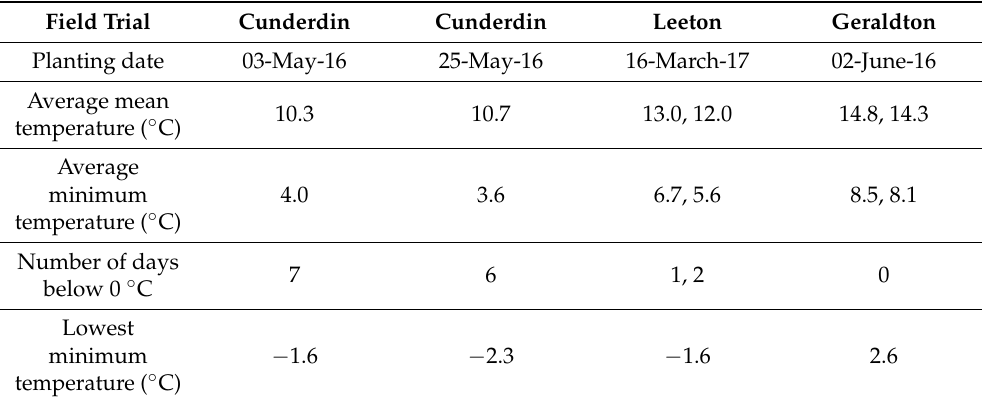
Figure 4. Relationship between average mean daily temperature for the 30-day period after com- mencement of flowering and seed yield for varieties BEW and JC1 at Cunderdin, Leeton and Geraldton. LSD ( p = 0.05) = 0.57. Table 17. Weather records at Cunderdin, Leeton and Geraldton field trial sites for the 30-day period after commencement of flowering of varieties BEW and JC1 (figures separated by a comma are data for BEW followed by data for